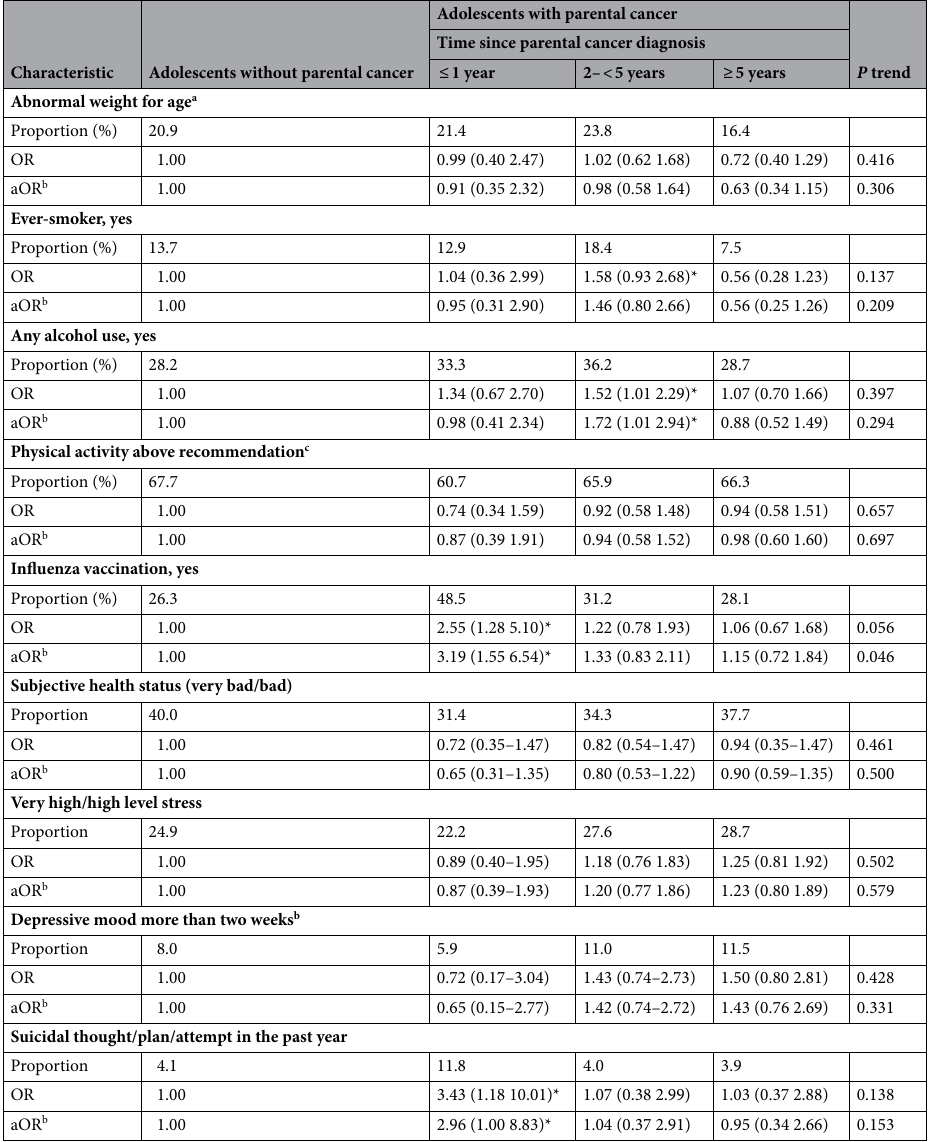
Table 3. Behavioral risk factors and psychological factors among adolescent according to time since parental cancer diagnosis. Data are presented as percentages (%) and odds ratio (95% CI). OR odds ratio; CI confidence interval. a Abnormal weight for age was defined as ≥ 95 percentile or < 5 percentile of weight for age of Korean adolescent population. b Adjusted for age, sex, and household monthly income. c Recommended physical activity (150 min/week of moderate-intensity physical activity, or 75 min/week of vigorous-intensity physical activity, or the equivalent dose of moderate and vigorous physical activity). * P <